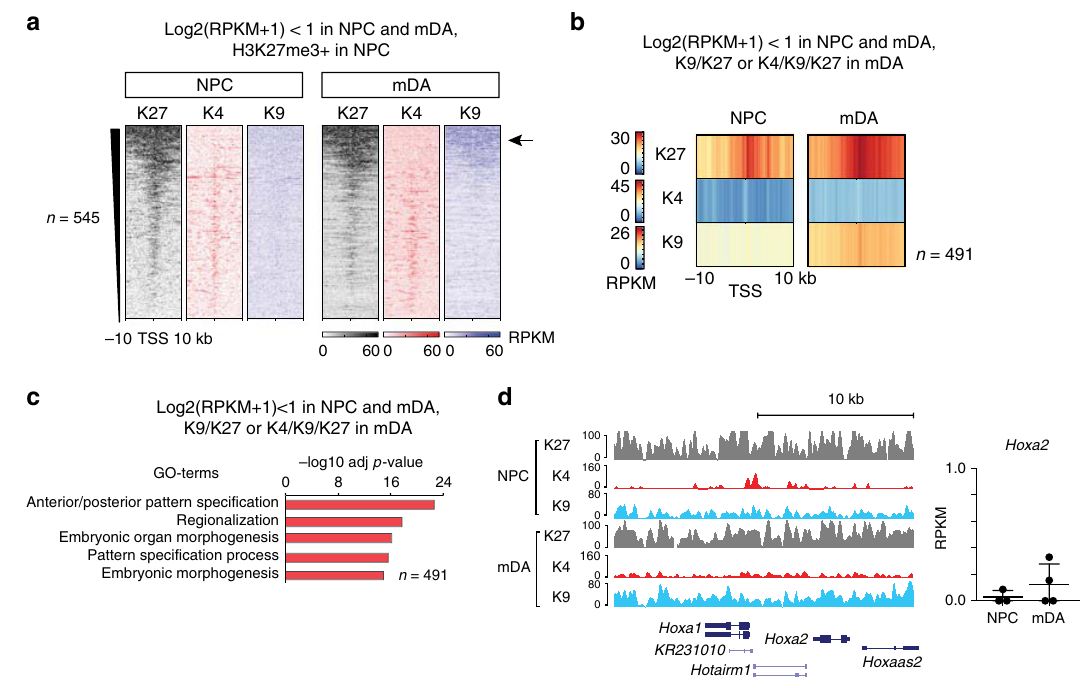
Fig. 4 Expansion of H3K27me3/H3K9me3 onto silenced genes in mDA neurons. a Genes repressed and H3K27me3-marked in both NPC and mDA gain H3K9me3 during terminal differentiation into mDA neurons: ChIP-seq heatmaps showing the abundance of H3K27me3, H3K4me3, and H3K9me3 as RPKMs ± 10 kb around TSS in NPC and mDA of silent (log2(RPKM + 1) < 1) and H3K27me3-marked genes in NPC. The arrow indicates a subset of silent and H3K27me3-marked genes displaying an increase in H3K9me3 in mDA compared to NPC. b Heatmap pro fi les of average H3K27me3, H3K4me3, and H3K9me3 RPKMs ± 10 kb around TSS of silent genes (log2(RPKM + 1) < 1) in NPC and mDA and categorized as K9/K27 or K4/K9/K27 in mDA. c Gene ontology (GO) of the top ( − log10 (adj p -value), Fisher ’ s exact test) biological processes for silent genes (log2(RPKM + 1) < 1 in NPC and mDA neurons as in b that were K9/K27 or K4/K9/K27 in mDA neurons ( n = 491). d Example of a silent and H3K27me3-marked gene in NPC that gains H3K9me3 in mDA: Left: UCSC Genome browser excerpt showing enrichment for H3K27me3 (gray, vertical scale 0 – 100 RPKM), H3K4me3 (red, vertical scale 0 – 160 RPKM), and H3K9me3 (blue, vertical scale 0 – 80 RPKM) within the Hoxa -locus. Right: Bars indicate average RPKM ± SD for Hoxa2 , which is <1 in NPC and